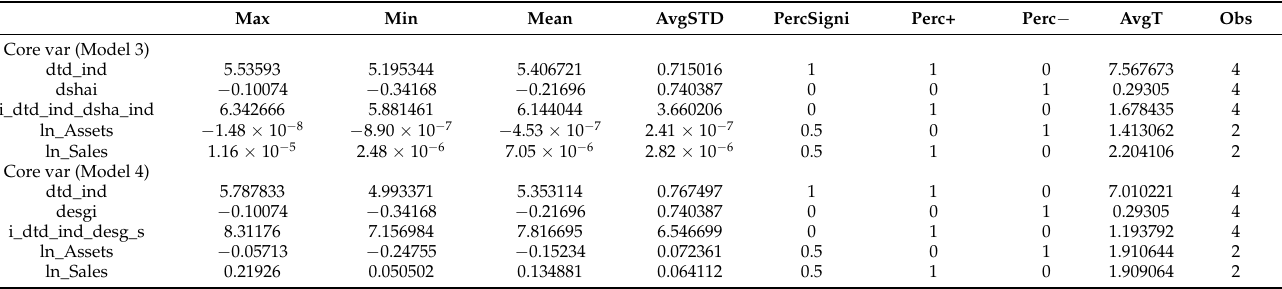
Table 6. CHECKROB (for static